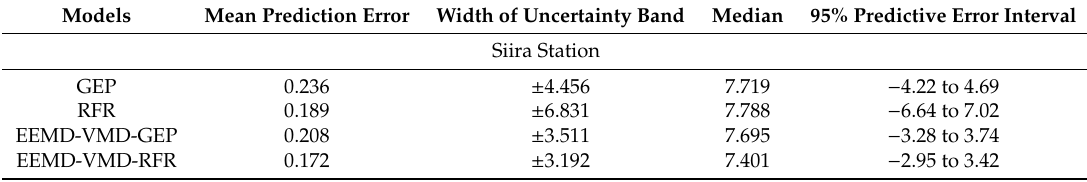
Table 6. Uncertainty analyses for streamflow prediction using predictive models at the Siira